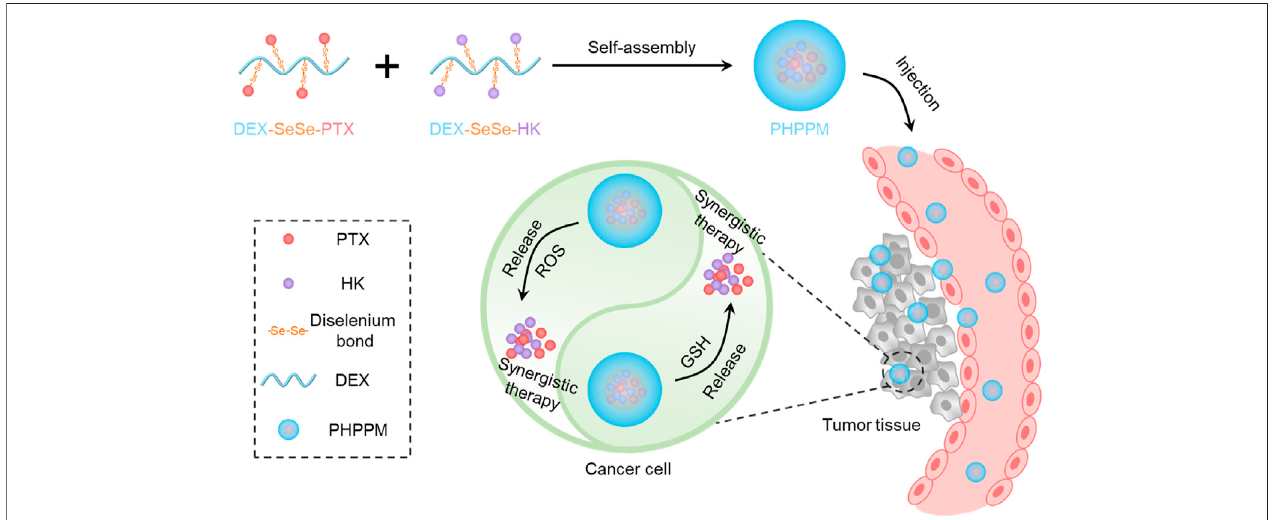
FIGURE 1 | Schematic illustration of the fabrication of paclitaxel and honokiol co-loaded cocktail polymeric prodrug micelles (PPM), and intracellular glutathione/ reactive oxygen species (ROS) dual-responsive drug release for precise combination therapy.